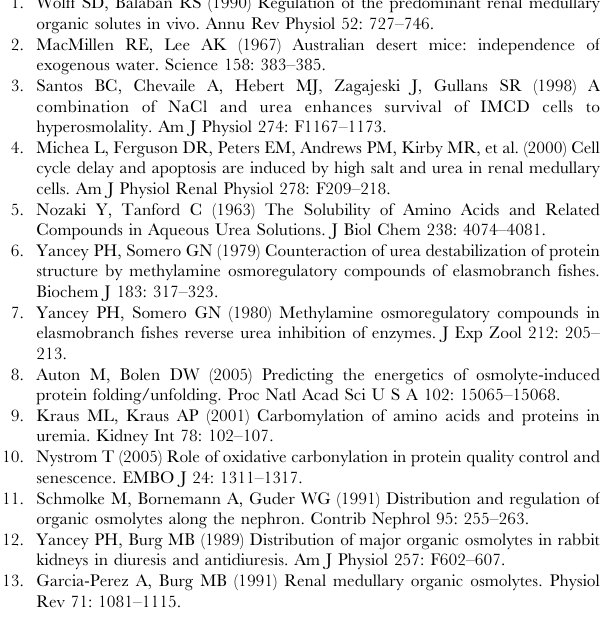
urea; Table S2. Thermodynamic parameters associated with the thermal unfolding of RNase-A at different pH values in the presence and absence of myo-inositol; Table S3. Thermody- namic parameters associated with the thermal unfolding of RNase- A at different pH values in the presence and absence of sorbitol; Table S4. Thermodynamic parameters associated with the thermal unfolding of RNase-A at different pH values in the presence and absence of taurine; Table S5. Thermodynamic parameters associated with the thermal unfolding of lysozyme at different pH values in the presence and absence of urea; Table S6. Thermodynamic parameters associated with the thermal unfolding of lysozyme at different pH values in the presence and absence of myo-inositol; Table S7. Thermodynamic parameters associated with the thermal unfolding of lysozyme at different pH values in the presence and absence of sorbitol; Table S8. Thermodynamic parameters associated with the thermal unfold- ing of lysozyme at different pH values in the presence and absence of taurine; Table S9. Thermodynamic parameters associated with the thermal unfolding of a -LA at different pH values in the presence and absence of urea; Table S10. Thermodynamic parameters associated with the thermal unfolding of a -LA at different pH values in the presence and absence of myo-inositol; Table S11. Thermodynamic parameters associated with the thermal unfolding of a -LA at different pH values in the presence and absence of sorbitol; Table S12. Thermodynamic parameters associated with the thermal unfolding of a -LA at different pH values in the presence and absence of taurine; Table S13. Thermal denaturation studies on proteins to see the counteracting effect of sorbitol with increasing urea concentration at pH